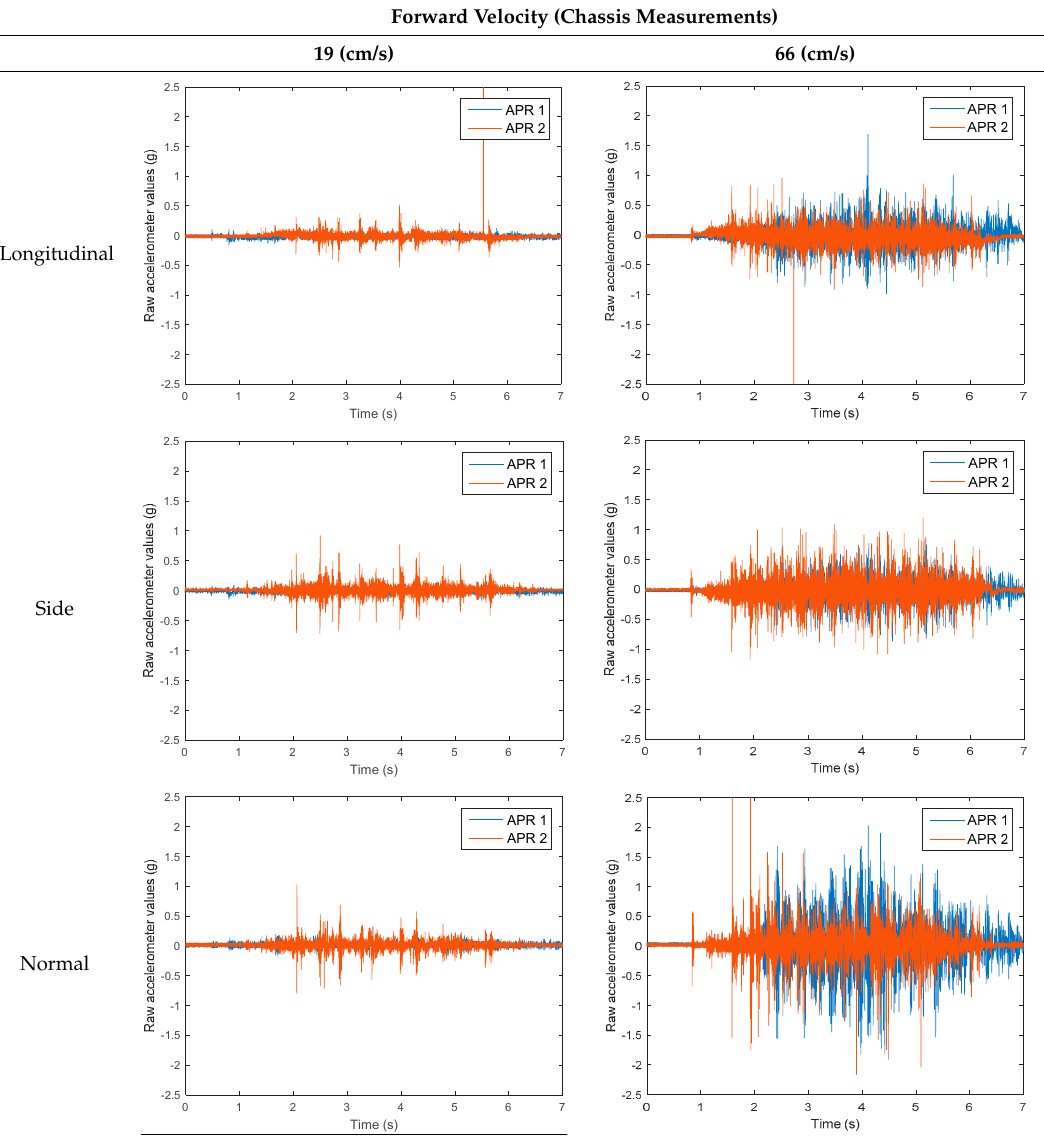
Table 4. Vibration representation measured in the chassis of the APR-1 and APR-2 prototypes.